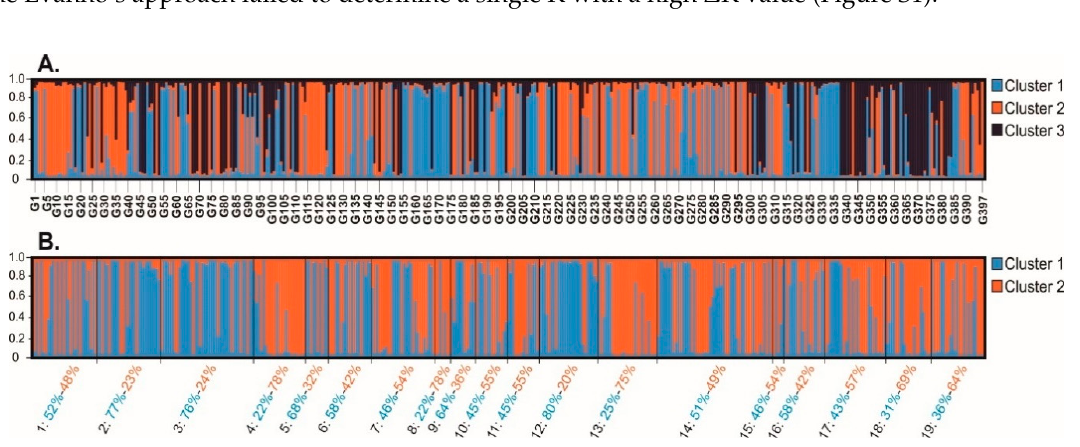
Figure 4. Assessment of population genetic structure by Bayesian cluster analysis of M. persicae in Tunisia. The clustering analysis was performed using an admixture model on (been referred) ( A ) 397 MLGs (assuming k = 3; see Materials and Methods and Figure S1); ( B ) 19 populations using one copy per MLG (assuming k = 2). The MLGs or populations are represented by vertical bars divided by colors according to their coefficients of ancestry to each cluster.